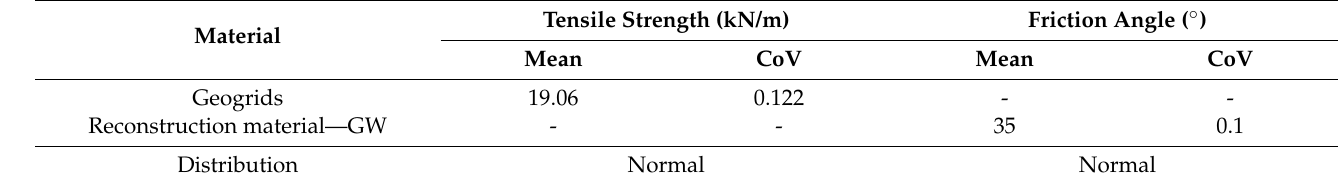
Table 3. Statistics of random variables.